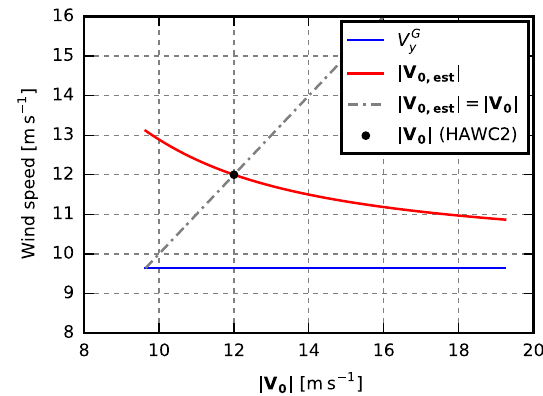
Figure 7. Example of free wind speed estimation. For | V 0 | = 12, the estimated free wind speed, | V 0 , est | , calculated with Eq. (29) equals | V 0 |